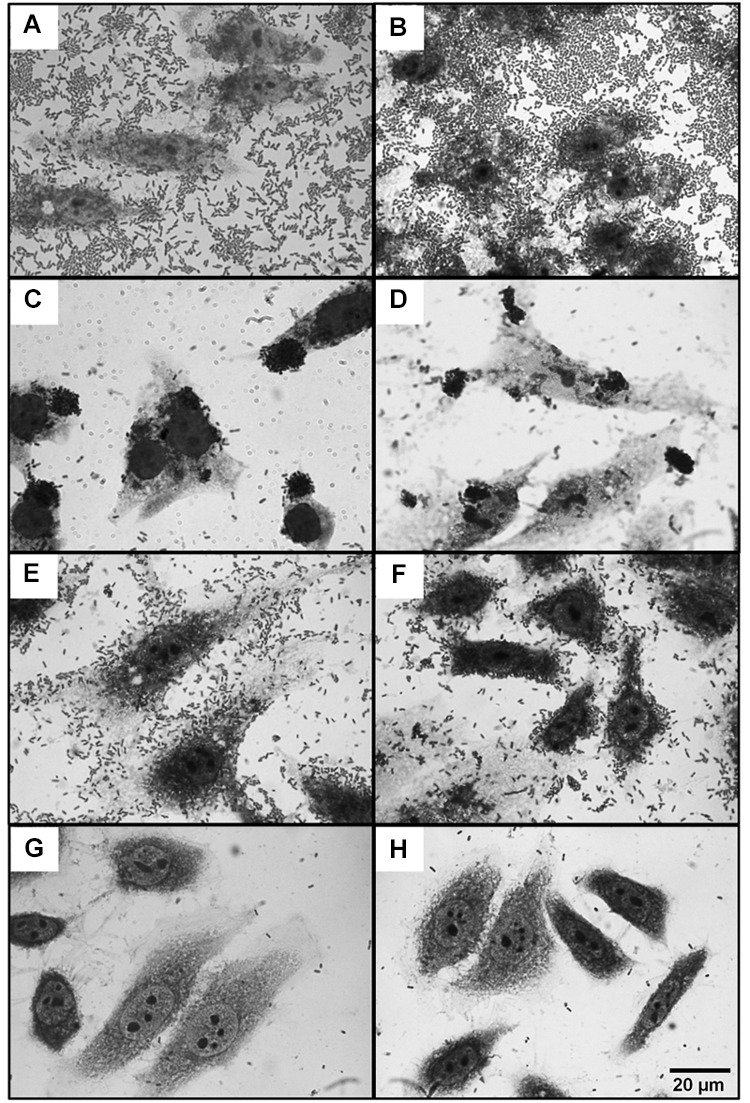
Adherence phenotype of diarrheagenic Escherichia coli (DEC) on in vitro-cultured HEp-2 cells. DEC cultures were used to infect HEp-2 cells for 3 h at 37°C, 5% CO2. Strains shown are (A) EAEC O42, (B) typical EAEC isolated from adult, (C) EPEC E2348/69 (D) typical EPEC isolated from children, (E) DAEC, (F) DAEC isolated from adolescent, (G)
E. coli K12, and (H) STEC isolated from children. Cells were stained by Giemsa and photographed using a 40X objective.